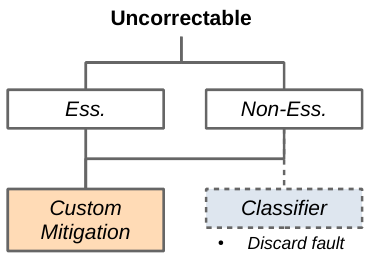
Figure 3. Fault Classification.